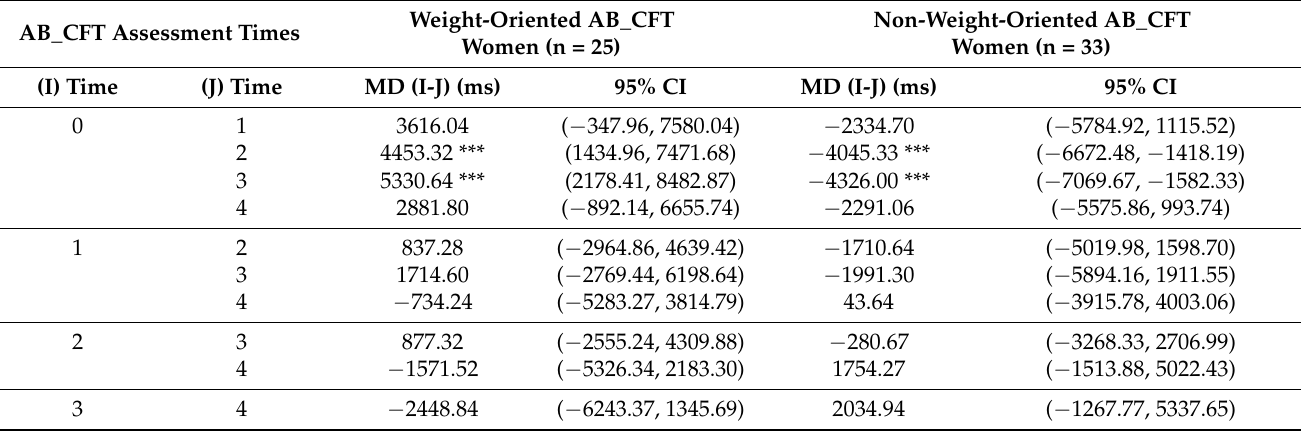
Note. AB_CFT mean differences (MD) and 95% confidence intervals (CI) stated for each group comparison. ms = milliseconds. AB_CFT assessment times: 0 at baseline, 1, 2, 3 and 4 respectively after ABMT series 1, 2, 3 and 4. Adjustment for multiple comparisons: Bonferroni. The mean difference is significant if *** p ≤